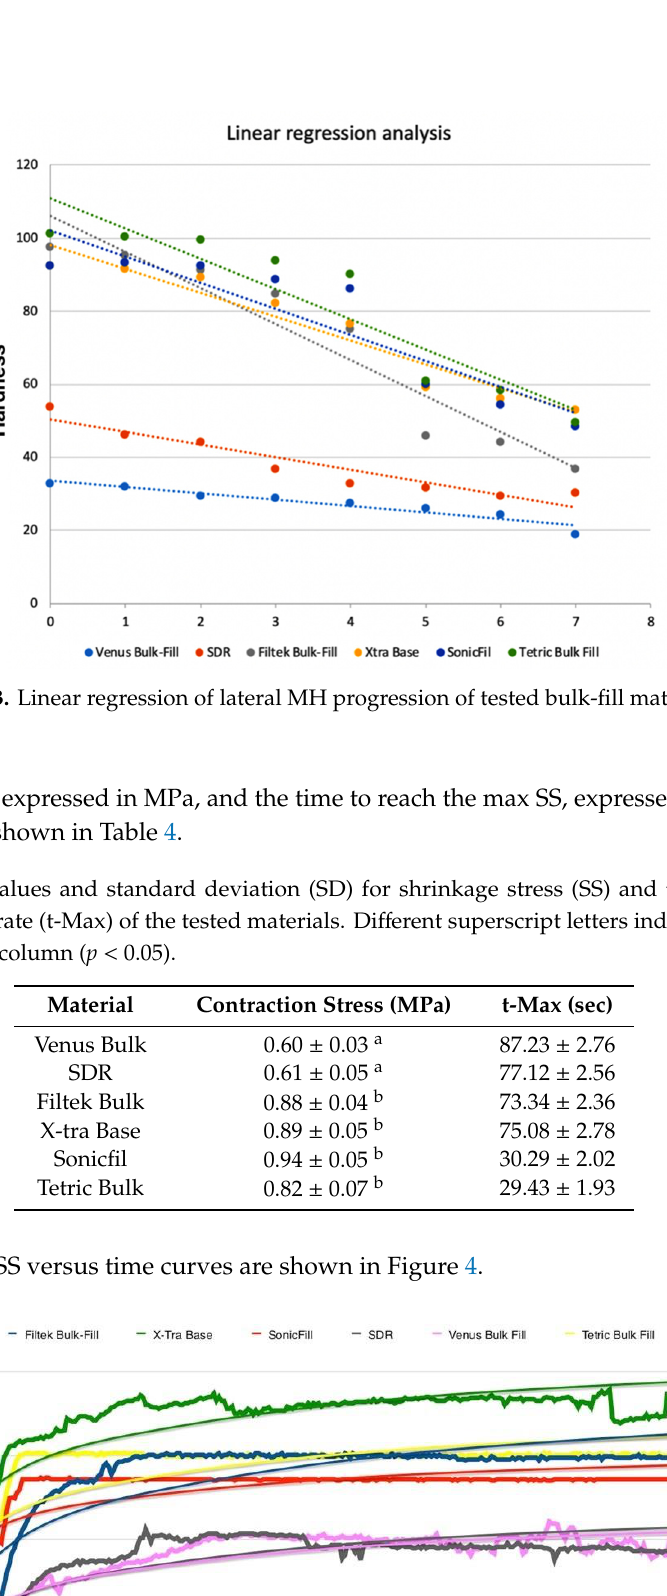
Figure 4. Plots of the SS (MPa) versus time (s) of the tested bulk-fill